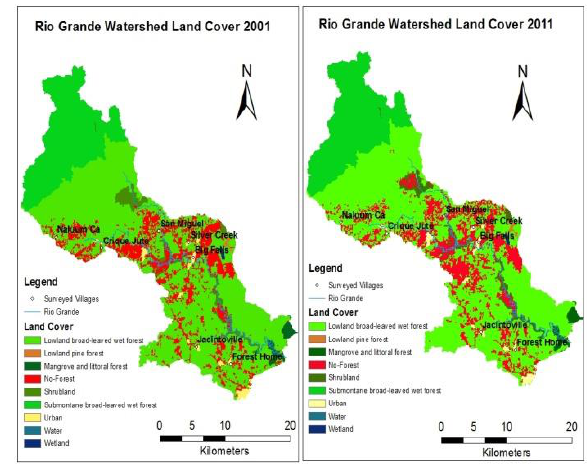
Figure 3. Rio Grande watershed land cover change in 2001 and